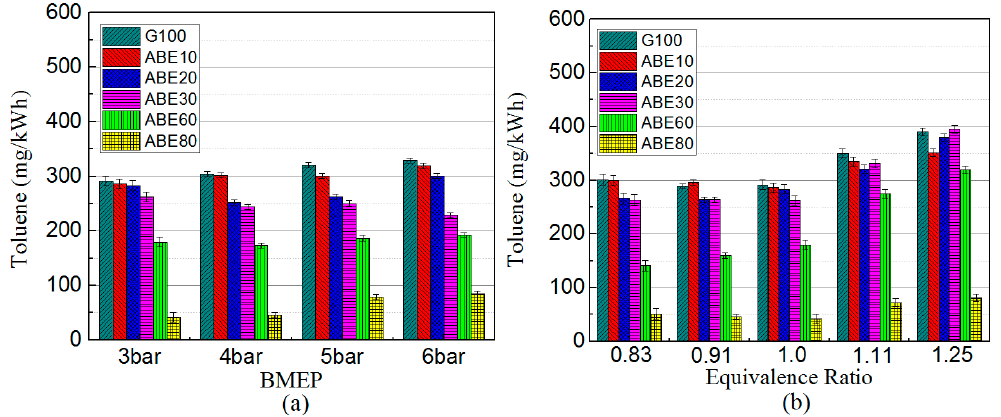
Figure 8. Toluene emissions at ( a ) stoichiometric conditions under different BMEP, and at ( b ) 3 bar BMEP under different equivalence ratios.